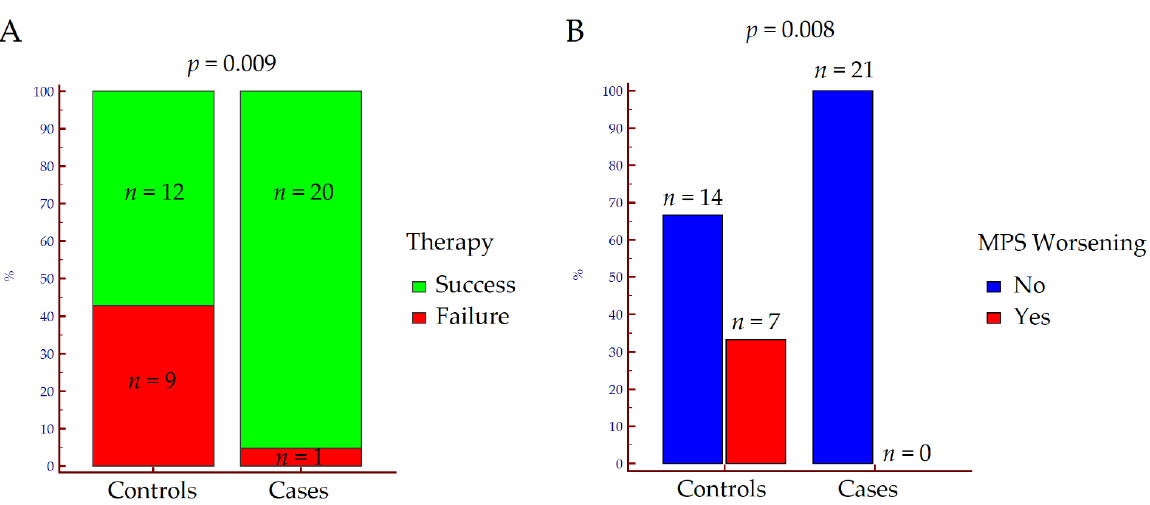
Figure 1. Rates of therapeutic success ( A ) and Mayo Partial Score worsening ( B ) at T2 according to treatment. p values were calculated by Fisher’s exact test. Abbreviations: MPS, Mayo Partial Score; n , number.